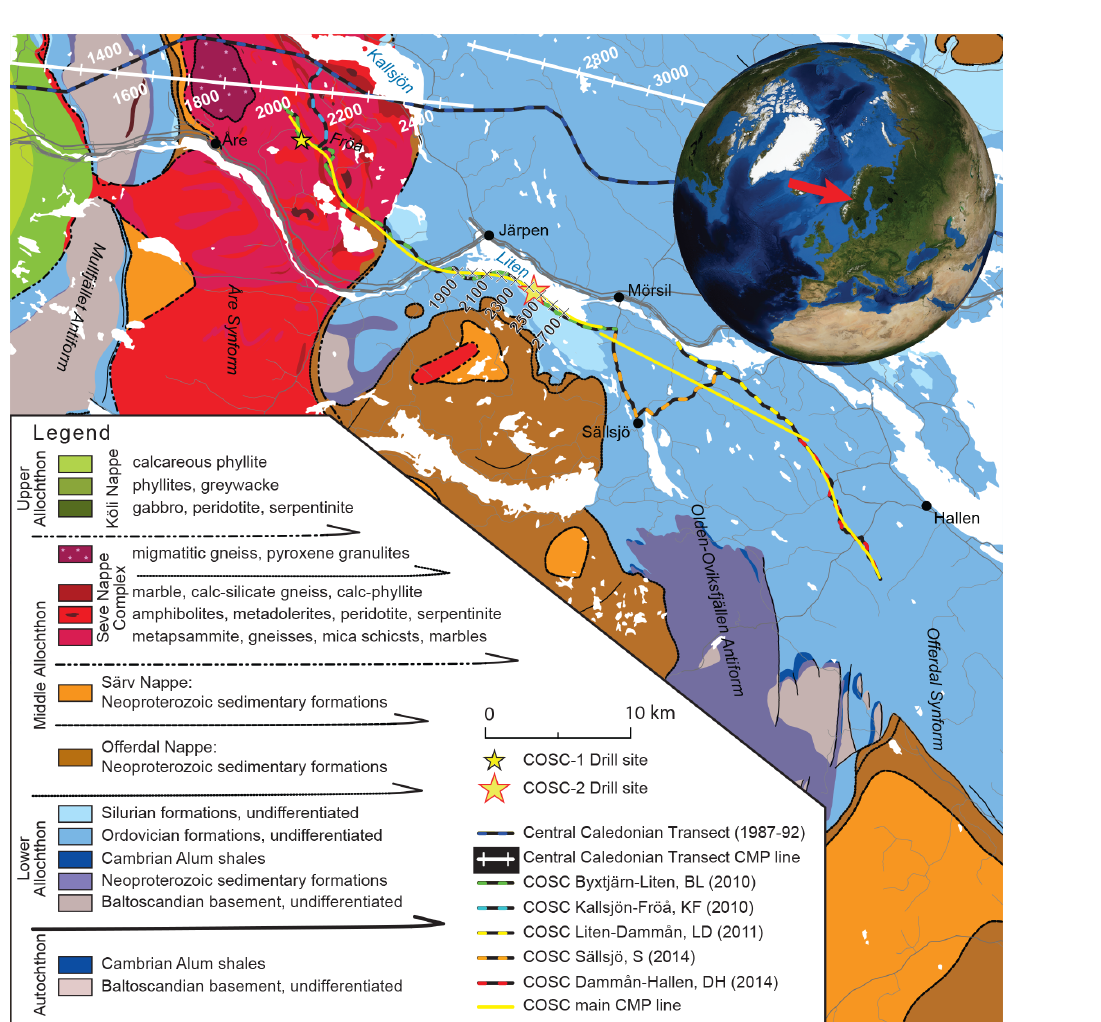
Figure 1. Tectonostratigraphic map of the Åre–Järpen area (based on the 1:200000 scale geological map by the Geological Survey of Sweden, I2014/00601; Strömberg et al., 1984). The map shows the COSC drill sites, the location of the regional seismic profiles of the Central Caledonian Transect (Palm and Lund, 1980; Juhojuntti et al., 2001), and the seismic lines of the COSC site investigations. Note that the common depth point (CDP) on the latter were shifted during reprocessing and, thus, are different from Hedin et al. (2012) and Juhlin et al. (2016). The magnetotelluric survey (Yan et al., 2016) followed the track of the COSC seismics. Figure modified from Juhlin et al.